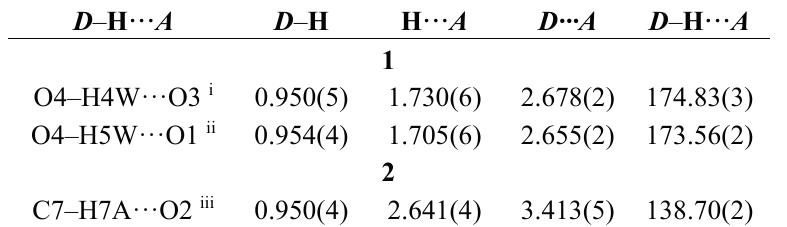
Table 2. Observed hydrogen bonds for studied complexes 1 and 2 (Å,